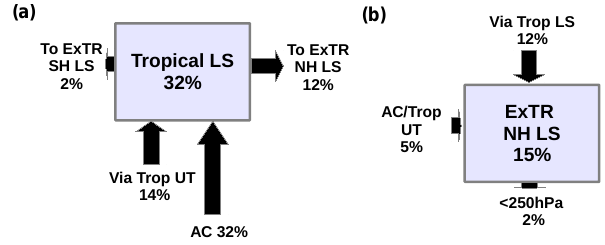
Figure 12. Total air parcel fluxes over 60 days (in percentage of total number of trajectories) into and out of (a) the tropical lower stratosphere and (b) the northern extratropical lower stratosphere. The numbers in the boxes are the fraction of trajectories that remain in the region after 60